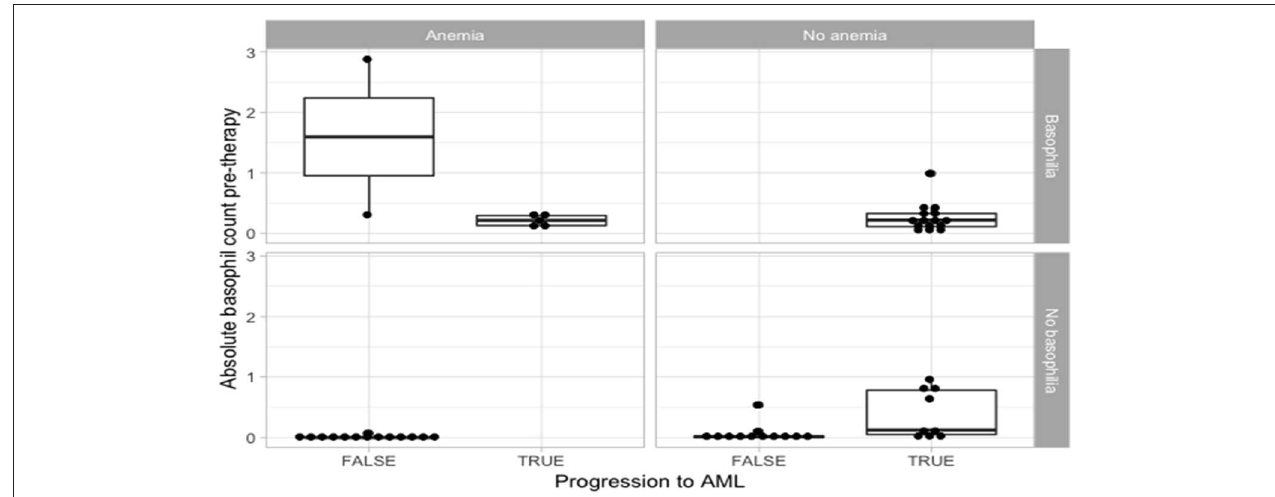
FIGURE 1 | Statistical analysis for the correlation of anemia and basophilia for the evolution of primary myelofibrosis towards acute myeloid leukemia.